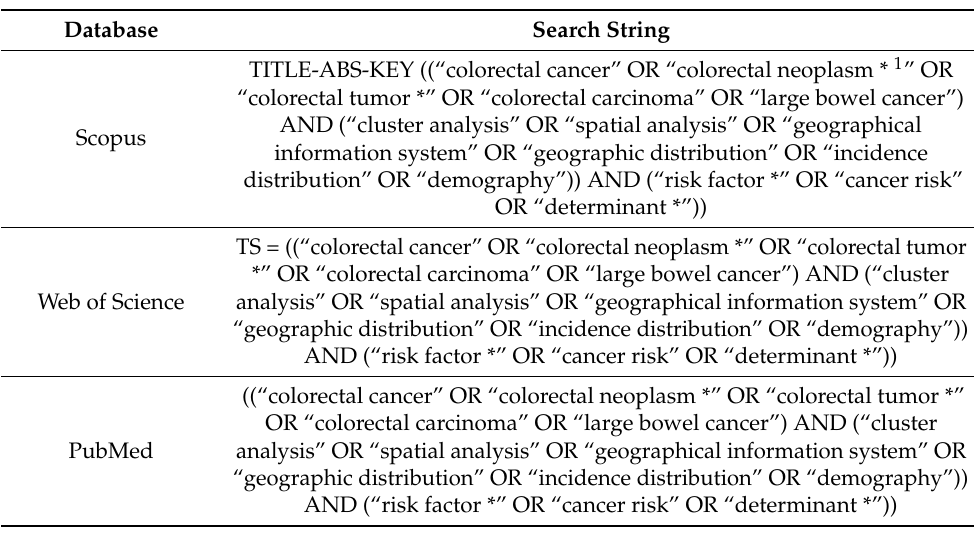
Table 1. Keyword search used in the identification